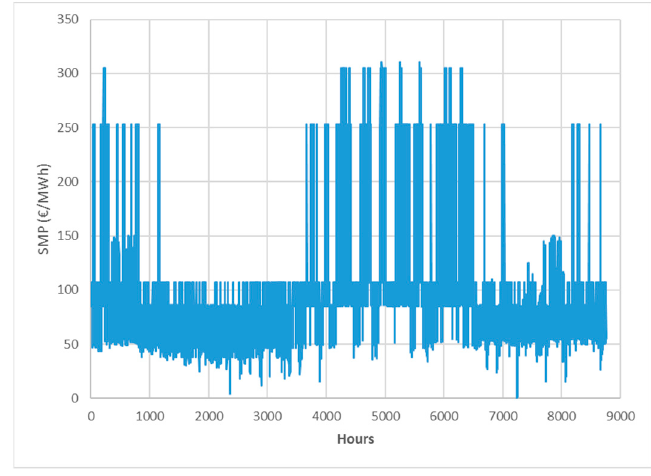
Figure 9. Annual variation of the SMP on Crete Island (current situation).